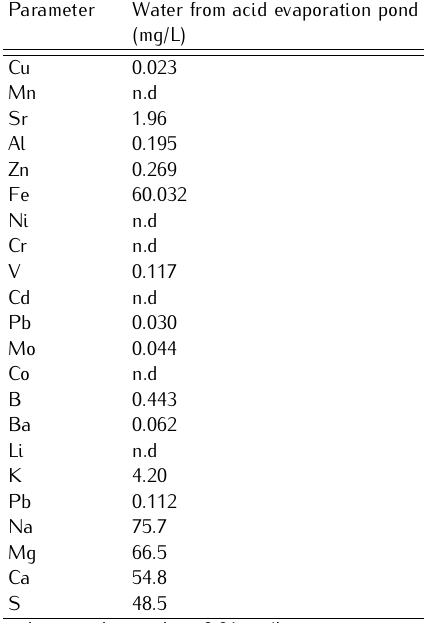
and slurry sample from tailings stockpile.